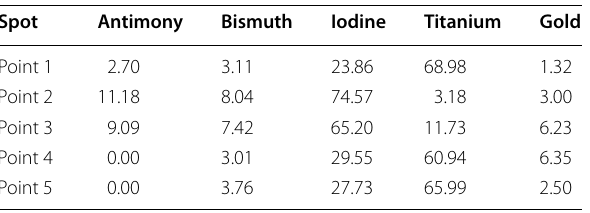
Table 1 Elemental distribution (atomic %) of the individual elements observed on particular spot